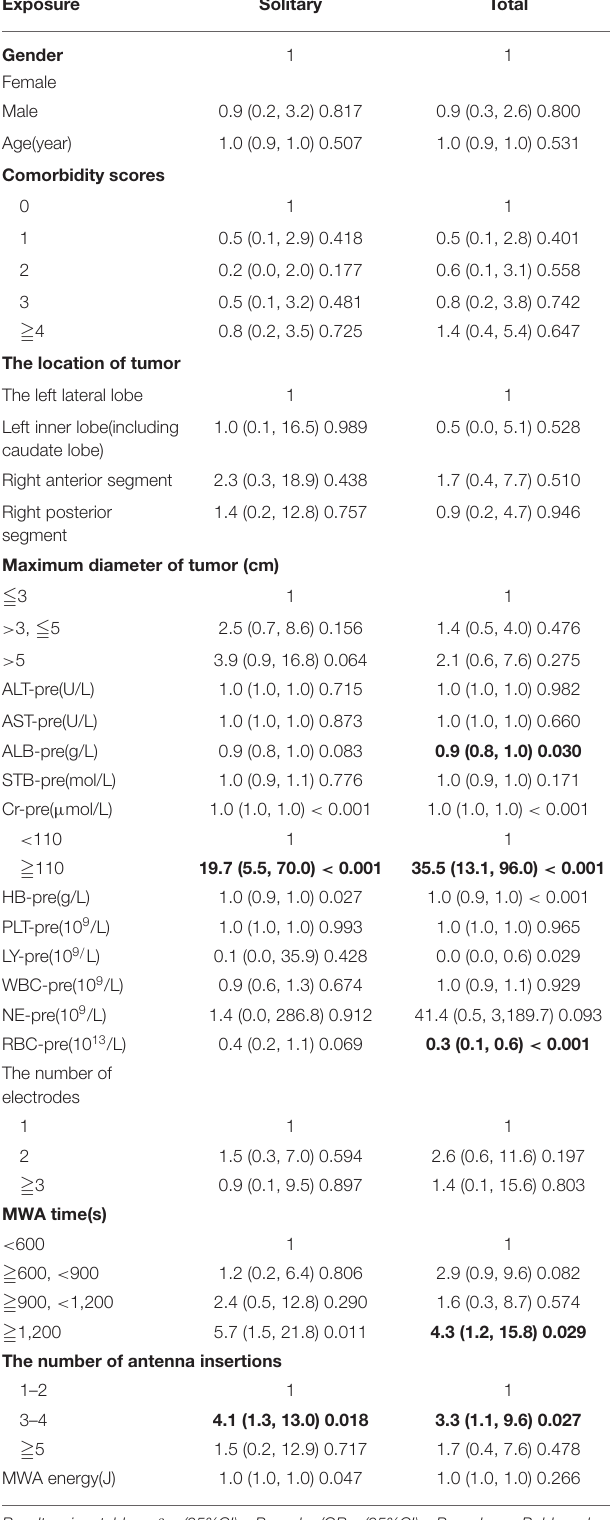
TABLE 4 | Multivariate analysis of acute kidney injury (AKI) (stages 1b, 2, and 3) for risk factors. Exposure Solitary